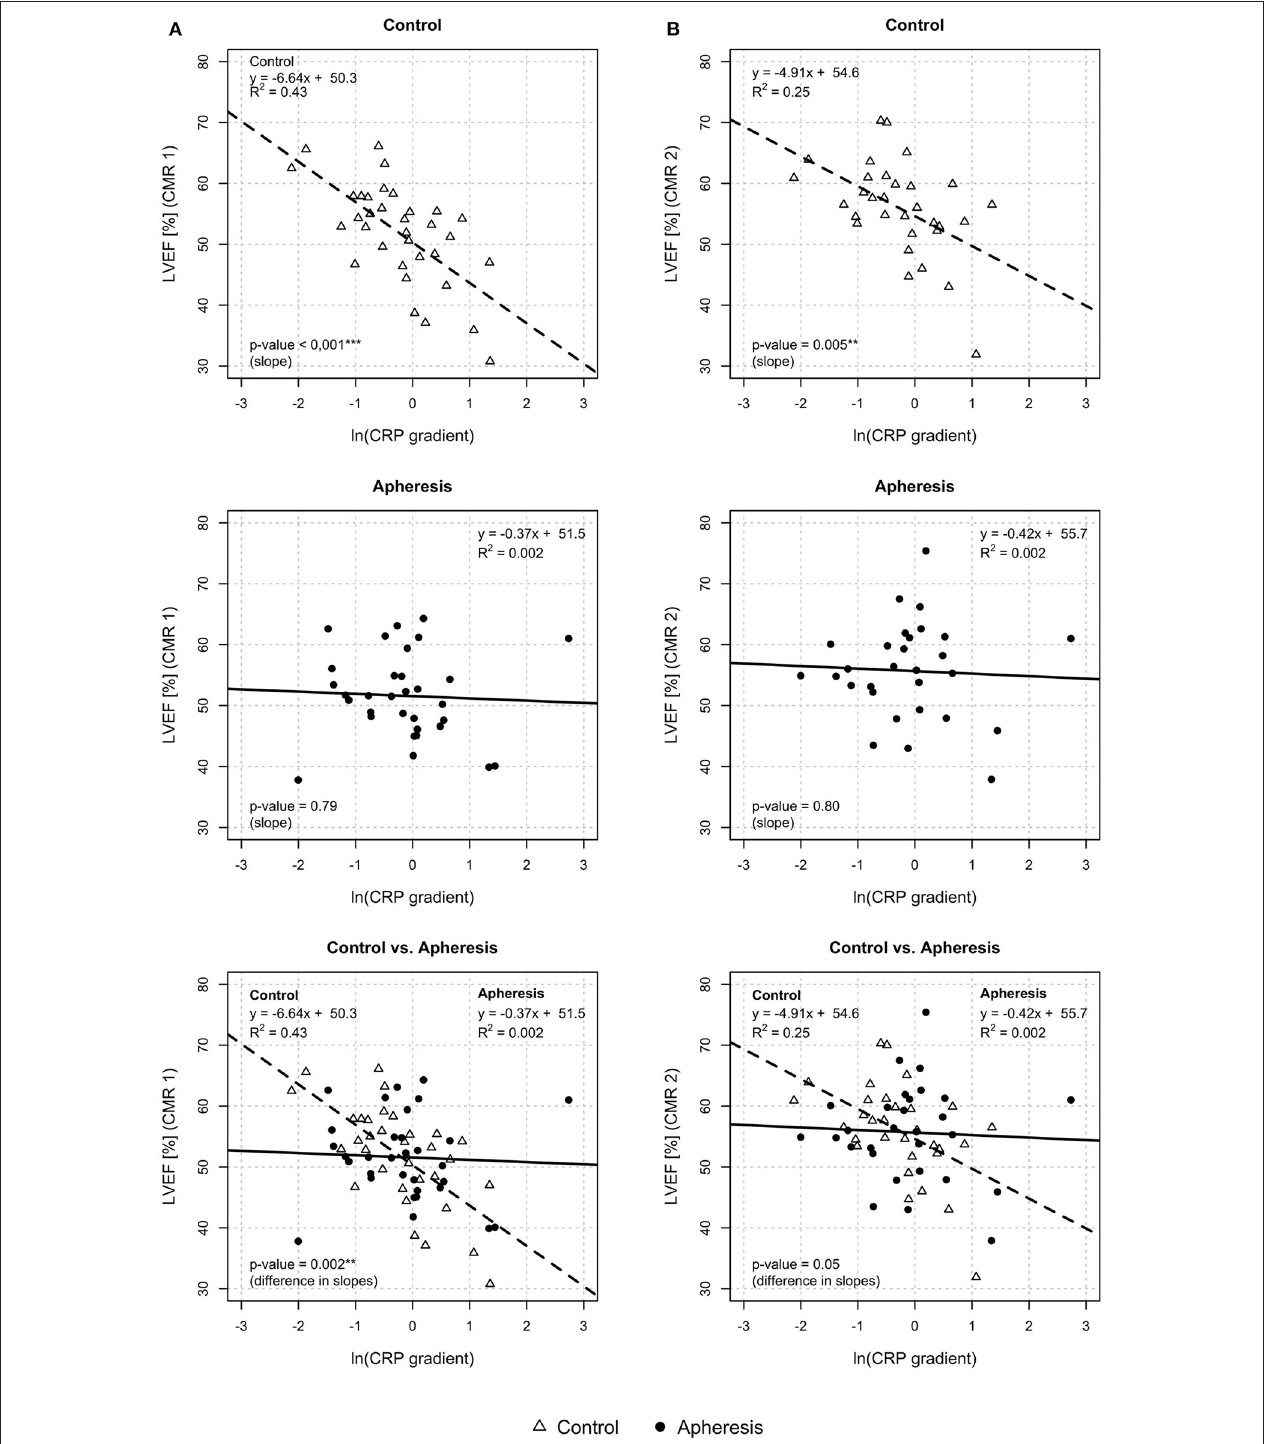
FIGURE 5 | Left ventricular ejection fraction (LVEF) and CRP gradient [ln(CRP gradient)] at CMR1 (A) and CMR2 (B) . CMR1—control group: Highly significant loss of LVEF with increasing values of the CRP gradient in the control group ( p < 0.001). Increase of ln(CRP gradient) by 1 unit reduces the LVEF by 6.6%. Apheresis group: Small loss of LVEF with an increase in CRP gradient in the apheresis group ( p = 0.79). Importantly, the two linear models differ highly significantly ( p = 0.002). CMR 2—control group: Significant loss of LVEF with increasing values of the CRP gradient in the control group ( p = 0.005). Increase of ln(CRP gradient) by 1 unit reduced the LVEF by 4.9%. Small loss of LVEF with an increase in CRP gradient ( p = 0.8). Importantly, the two linear models differ significantly ( p = 0.05).